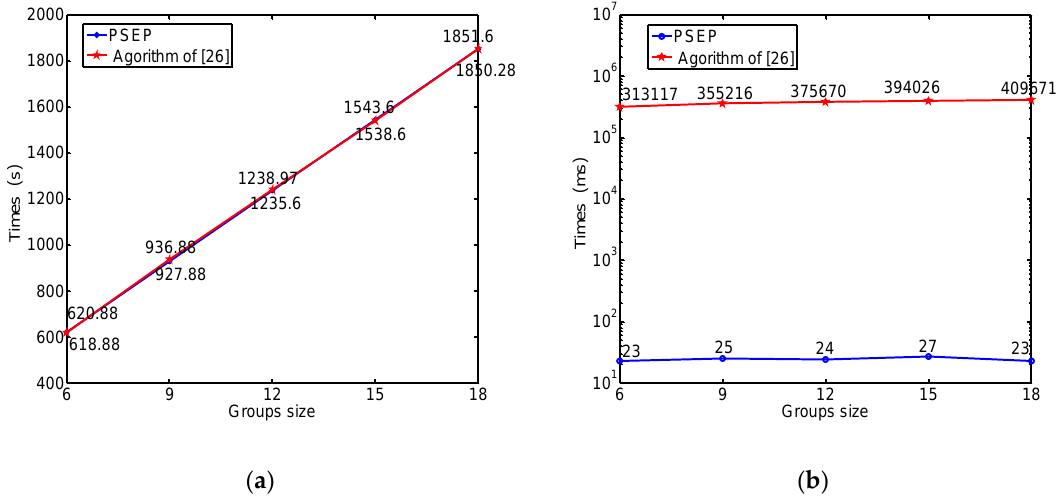
Figure 18. The comparative results when the group size is uniform. ( a ) The change of the total evacuation time with the increasement of the number of groups; ( b ) The change of the operation time with the increasement of the number of groups.